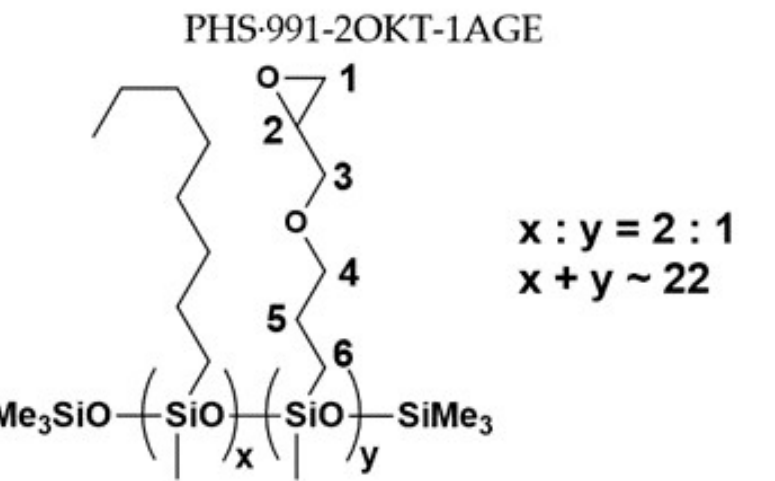
6 of 20 Scheme 1. The scheme of the structure of the MFSC 1 modifier. 1 H NMR (400 MHz, CDCl 3 ):  (ppm) = 3.71–3.68 (m, position 3), 3.47–3.41 (m, position 3 and 4), 3.14 (m, position 2), 2.80–2.78 (m, position 1), 2.61 (m, position 1), 1.64–1.61 (m, position 5), 1.32–1.28 (m, hexyl -CH 2 -), 0.90–0.88 (m, hexyl -CH 3 ), 0.54–0.53 (m, SiCH 2 -), 0.13–0.06 (s, SiMe, SiMe